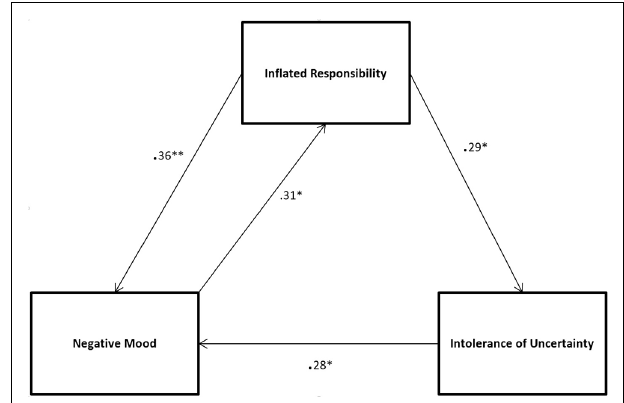
FIGURE 1 | Significant direct relationships between the three constructs to emerge from Experiments 1–3. Standardized beta values and their significance (* p < 0.05, ** p < 0.01) are reported. Note that significant indirect effects are not